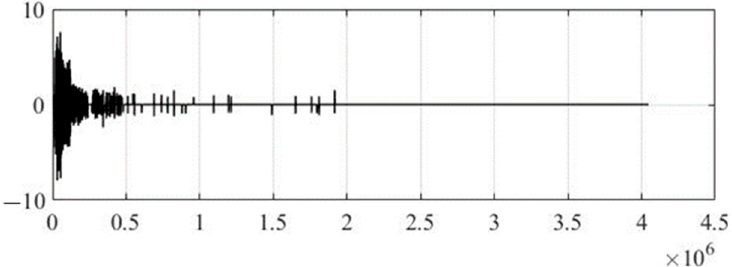
Figure 11. Wavelet coefficients of compressed steganocoded audio signal by 20 times with full integrity of text information (developed method).